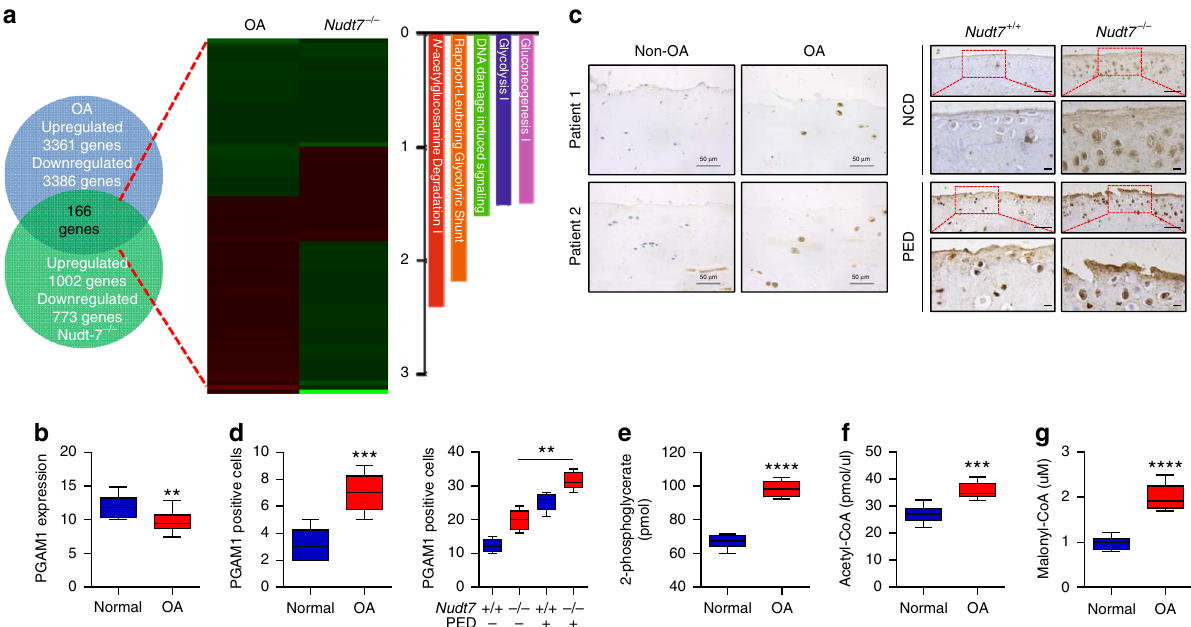
+/+ +/+–/– –/– ++–– Fig. 3 NUDT7 de fi ciency affects glycolysis via upregulation of phosphoglycerate mutase 1 (PGAM1) expression during osteoarthritis (OA) pathogenesis. a Comparison of RNA sequencing between human OA chondrocyte and cartilage of Nudt7 − / − mice, and possible pathological signaling pathways using Ingenuity Pathway Analysis (IPA). b Transcription level ( Δ Ct value) of PGAM1 in human OA chondrocytes ( n = 15) compared with that in normal chondrocytes ( n = 8). c Immunohistochemistry of PGAM1 in human OA cartilages ( n = 5 per group) and cartilages of Nudt7 − / − mice ( n = 5 per group) under NCD or PED conditions. Scale bars, 50 μ m. d Positive cell number of PGAM1 in human OA cartilages ( n = 5 per group) and cartilages of Nudt7 − / − mice ( n = 5 per group) under NCD or PED conditions from Fig. 3c. e – g Analysis of 2-phosphoglycerate, acetyl-CoA, and malonyl-CoA in immature murine articular chondrocytes (iMACs) of Nudt7 − / − mice at postnatal day 6 ( n = 6 per group). Values are means + s.d. An unpaired Student ’ s t test was used for statistical analysis. ** P < 0.01, *** P < 0.001, **** P <